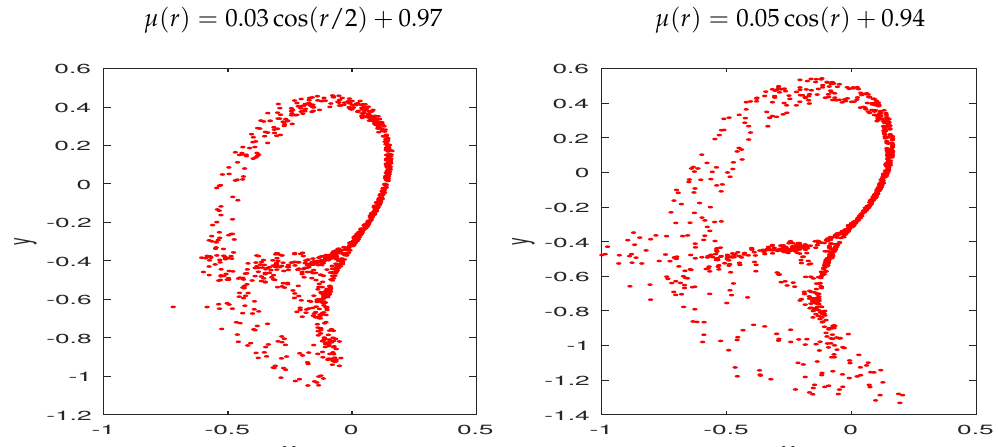
Figure 2. Phase portraits of the Tinkerbell map with fractional variable-order (8) with distinct fractional